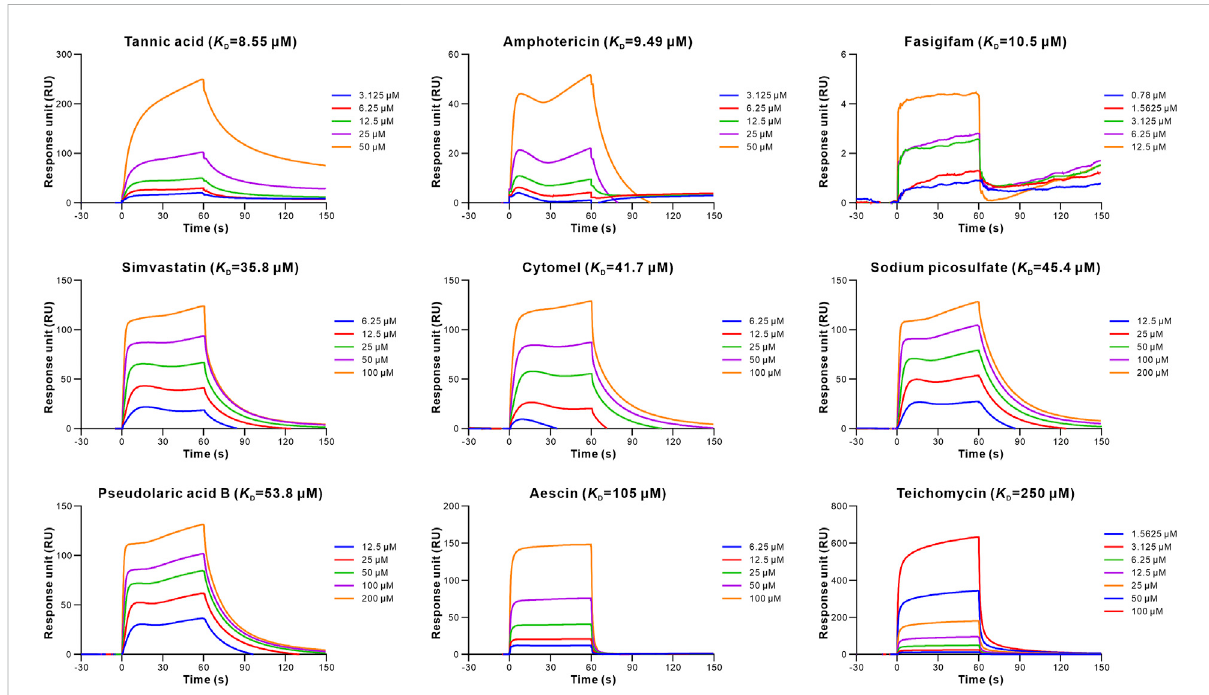
FIGURE 3 BindingoftheretrieveddrugstohACE2.SPRanalysiswasperformedtoassesstheretrieveddrugsbindingtohACE2atgradientconcentrations. The binding curves were analyzed using a kinetic analysis supplied with Biacore Evaluation Software. Data are presented as RU over time (s). The K D were calculated using a 1:1 binding model.